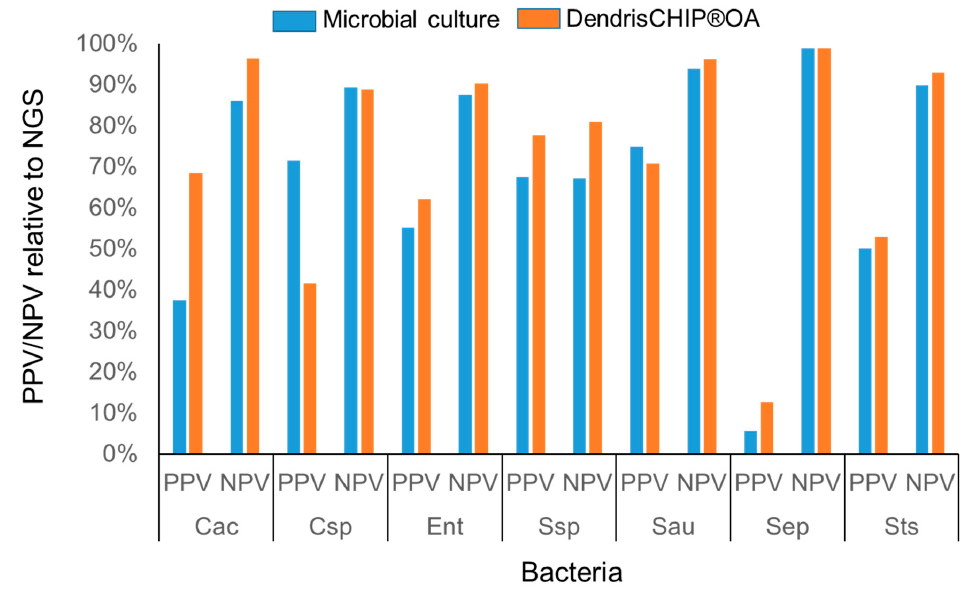
Figure 3. Evaluation of the predictive positive and negative values (PPV; NPV) of diagnostic tests by DendrisCHIP ® technology and microbial cultures relative to NGS data obtained from 101 iso- lates.